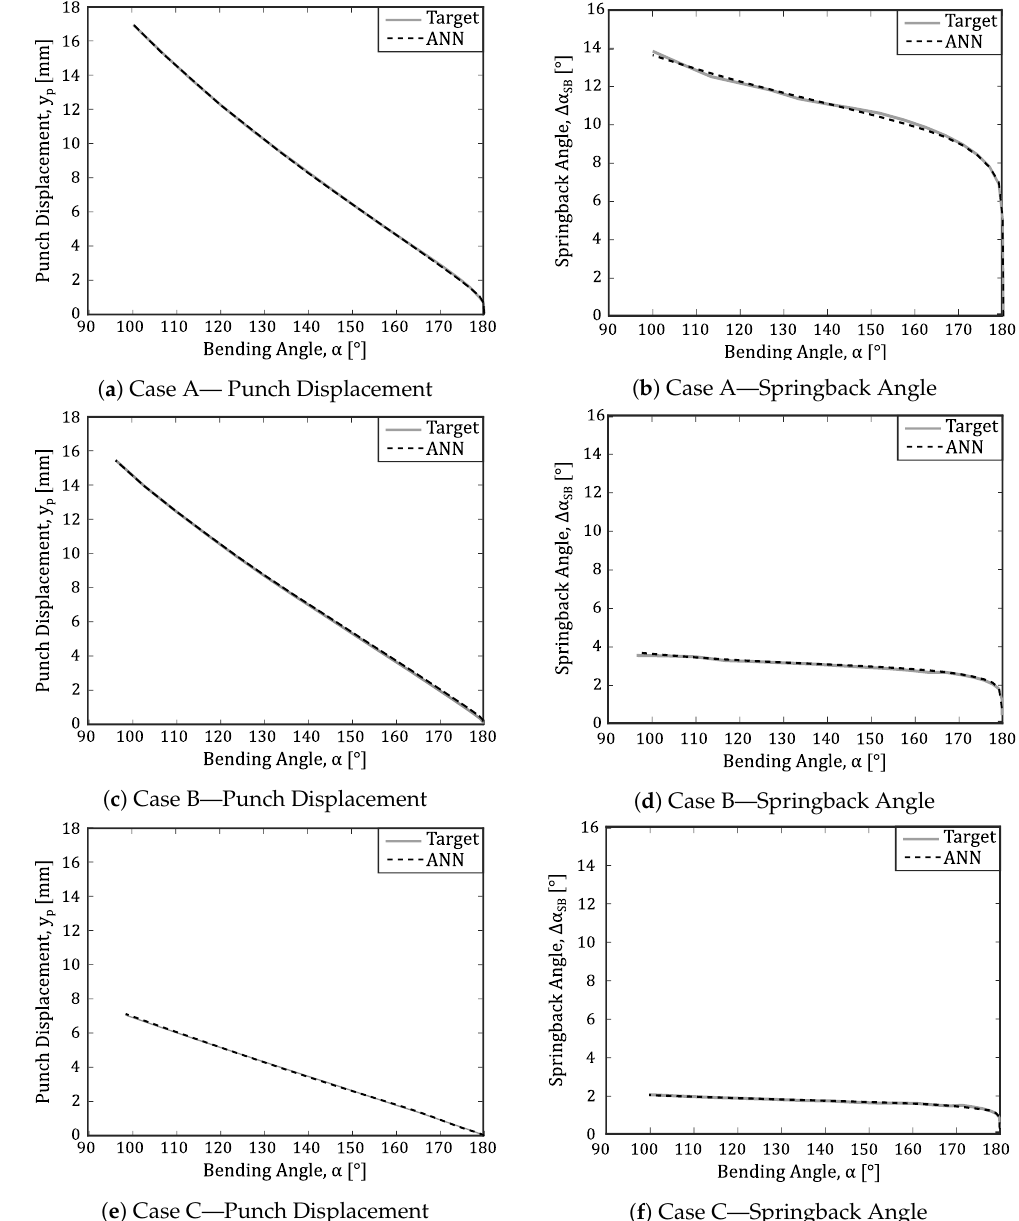
Figure 21. Punch displacement ( y p ) graphs and springback angle ( ∆ α SB ) graphs as a function of required bending angle ( α ) for cases A, B,